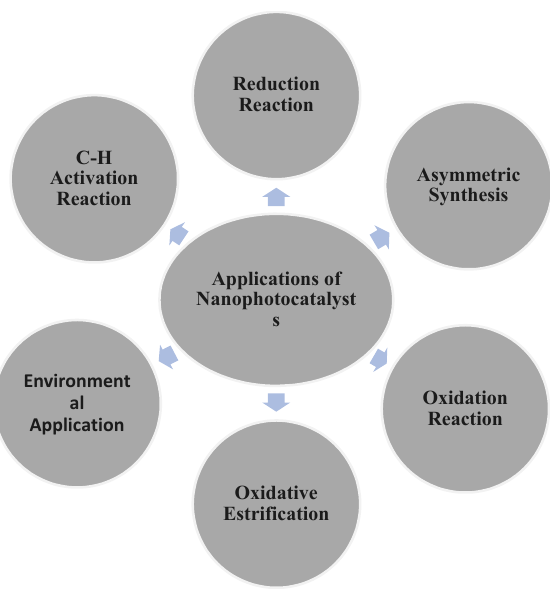
Figure 1. Potential applications of nanophotocatalysts.